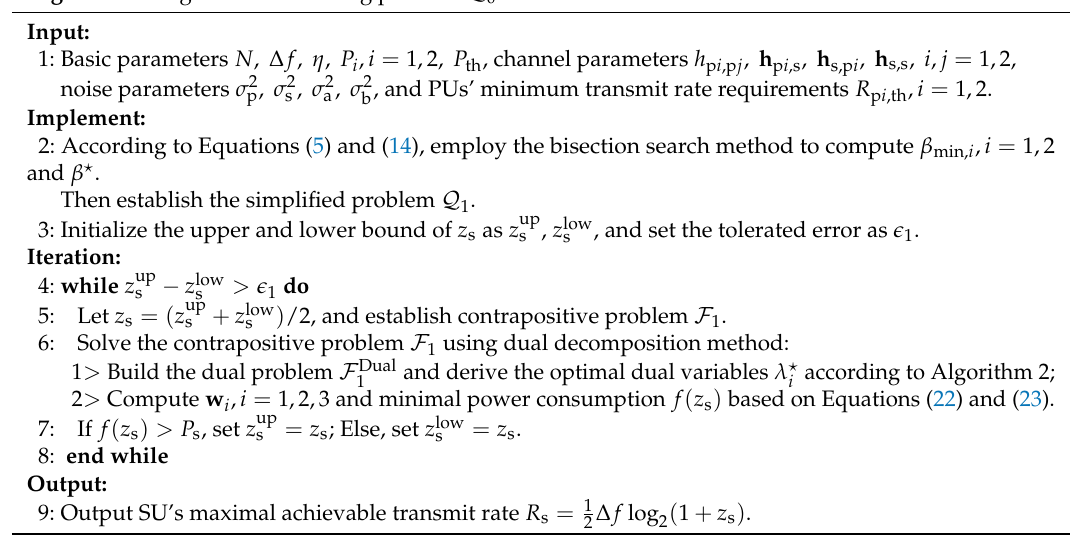
Algorithm 1 Algorithm for solving problem Q 0 .